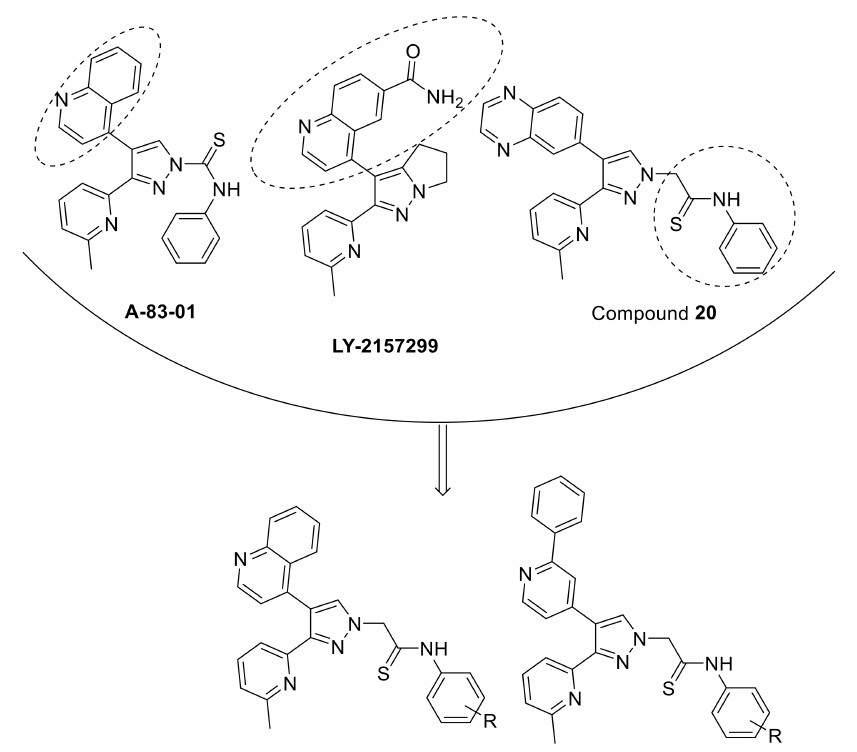
Figure 90. Schematic view of the rationale behind designing the series of compounds as ALK5